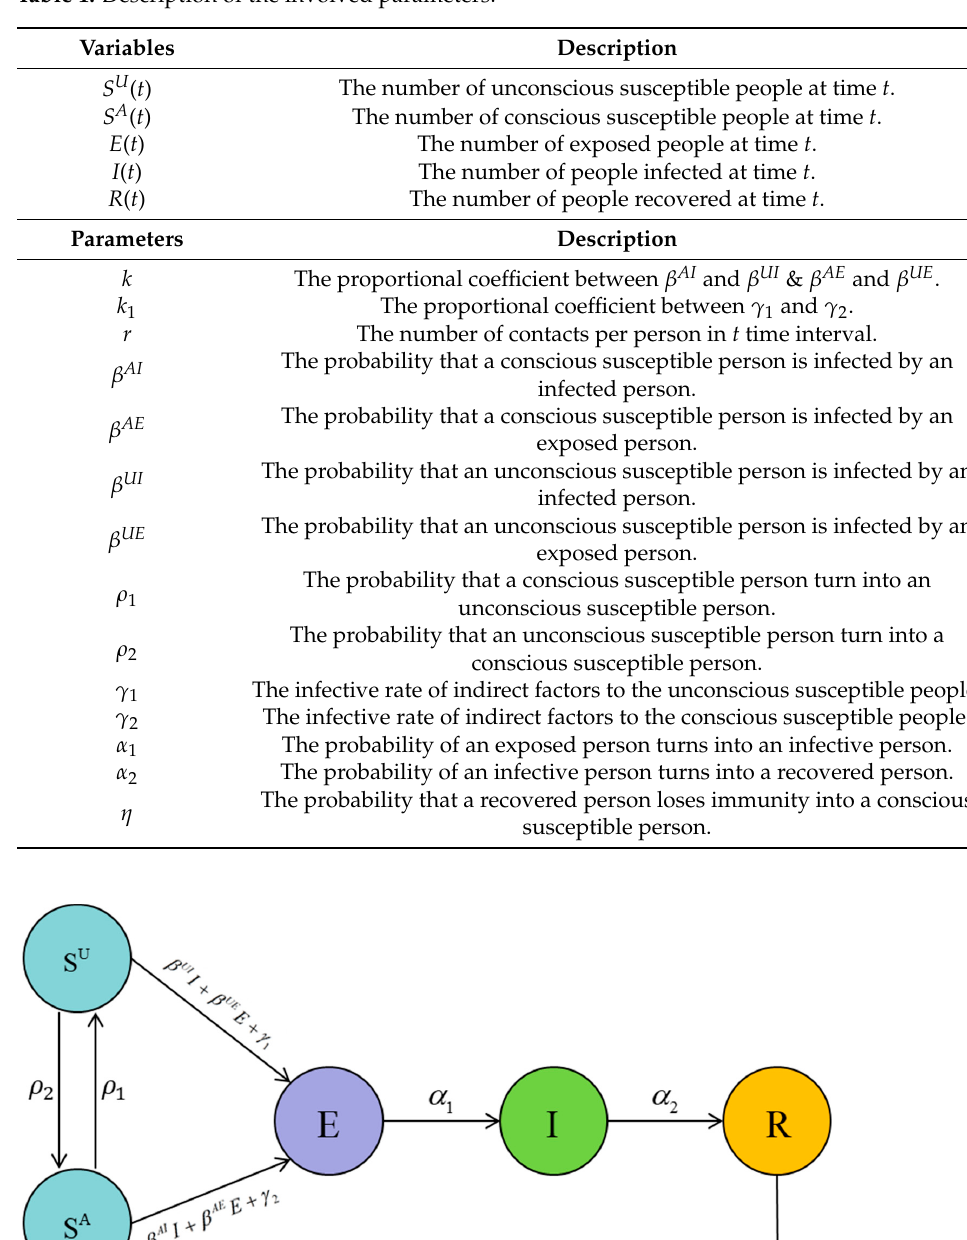
Table 1. Description of the involved parameters.